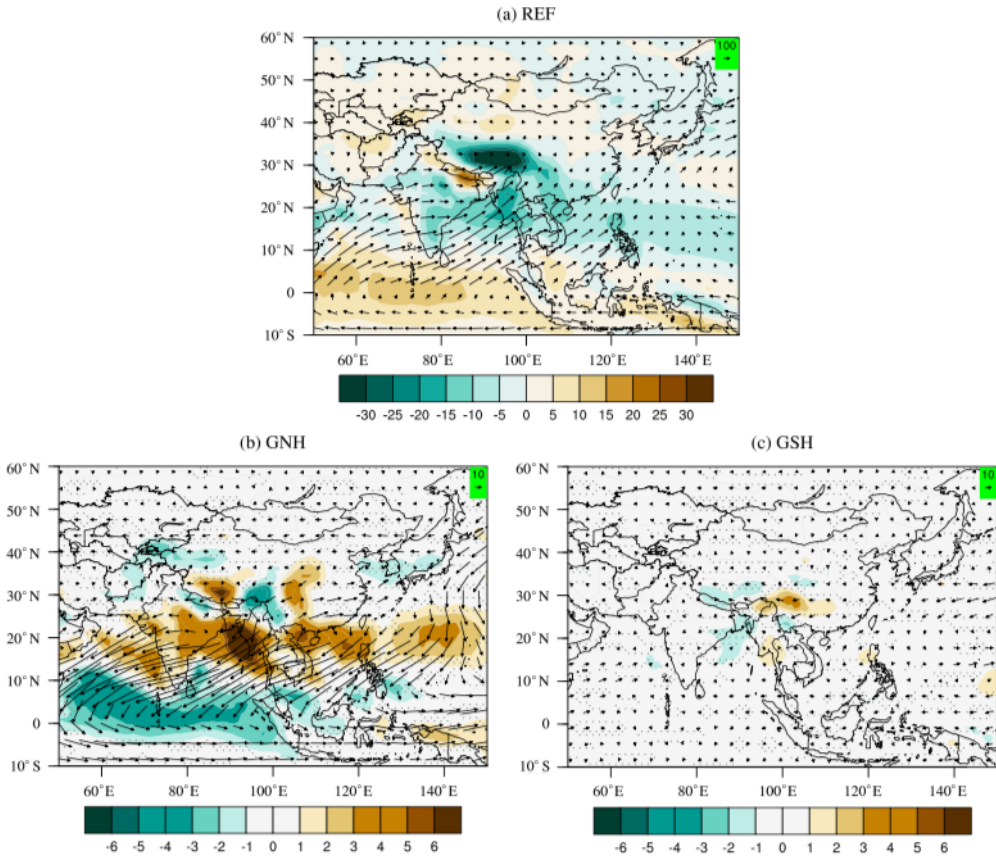
Figure 8. JJA mean vertically integrated moisture transport (IVT – vector; kgm − 1 s − 1 ) and its divergence (IVTD – shaded; kgm − 2 s − 1 ) 5 years before the eruption ( a ; REF) and the anomalies in the eruption year of the GNH (b) and GSH (c) classifications. The gray dots in (b) and (c) mark the insignificant results at the 95% confidence level. The scale of the wind arrow is shown in the green box in the top-right corner of the panel. Note that the scales of the colors and arrows are different between the top and bottom panels of the figure.